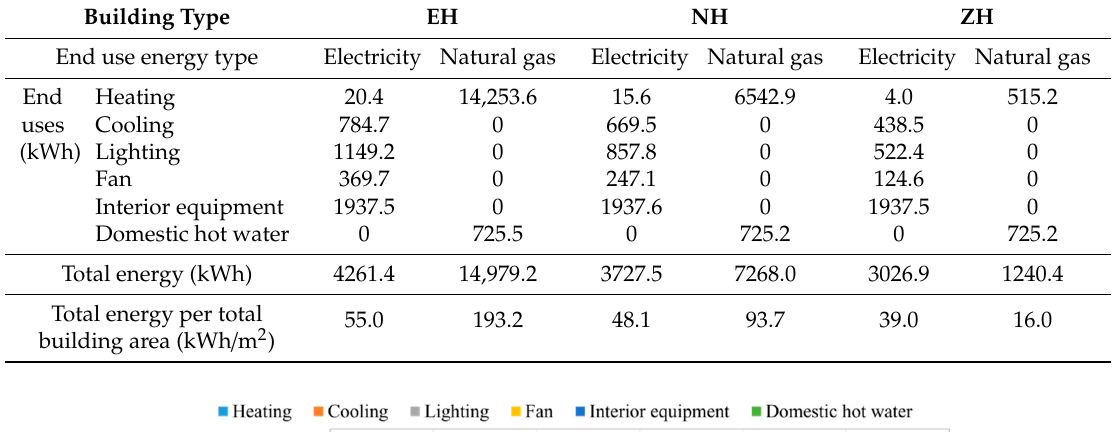
Table 11. Annual energy consumption by end uses.